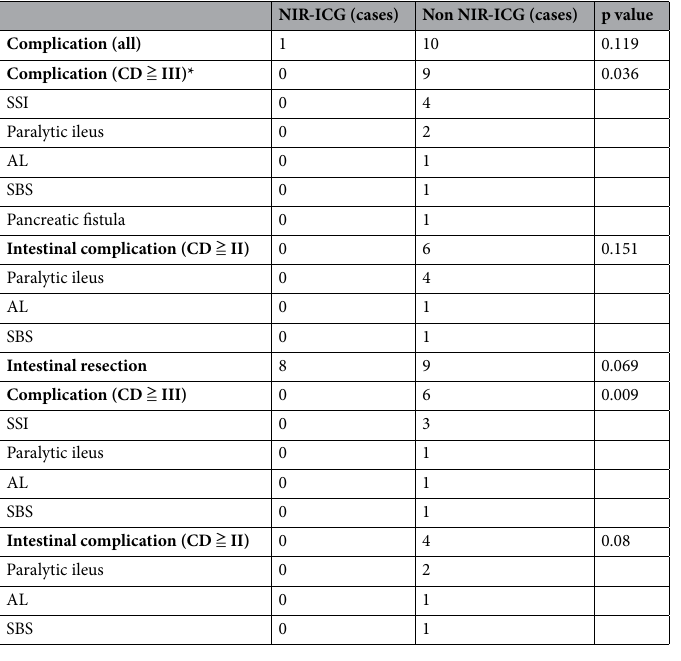
Table 2. Postoperative complications of the NIR-ICG group and the non-NIR-ICG group. *Once excluded “pancreatic fistula” which is not an intestinal complication, p-value would be 0.076 for cases limited to intestinal-related complications.